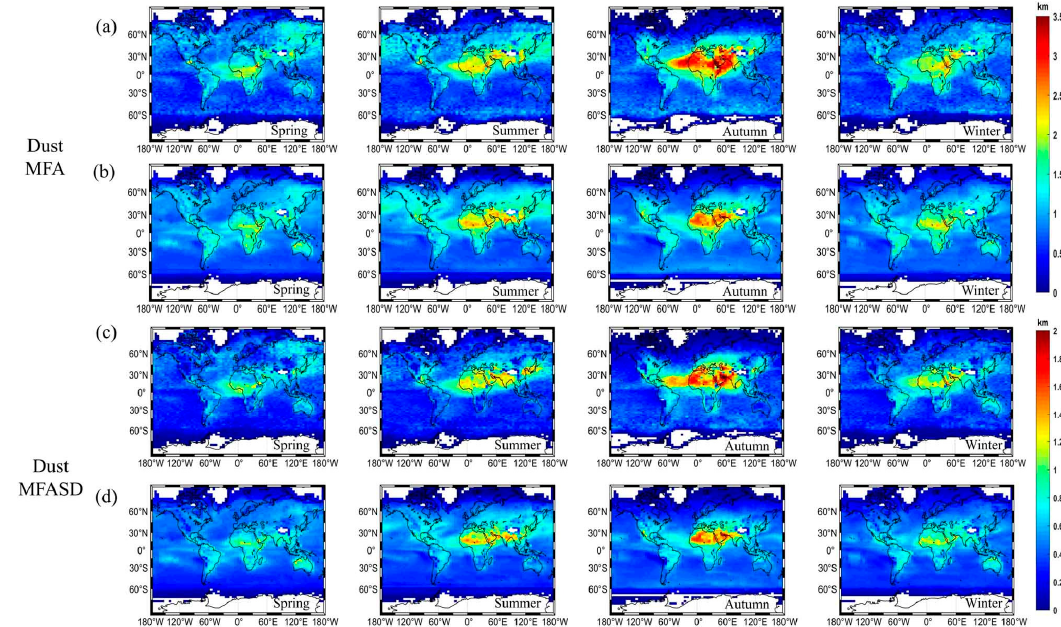
Figure 10. Comparisons between model predictions and CALIPSO observations for the dust aerosol. ( a ) CALIPSO observed MFA; ( b ) model predicted MFA; ( c ) CALIPSO observed MFASD; ( d ) model predicted MFASD. White shading indicates insufficient available data.